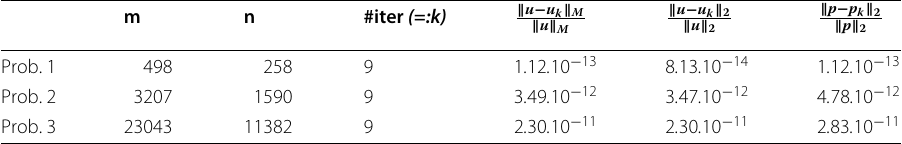
Table5 Example prestressed concrete: GKB convergence for (cid:6) GKB = 10 − 5 and d =